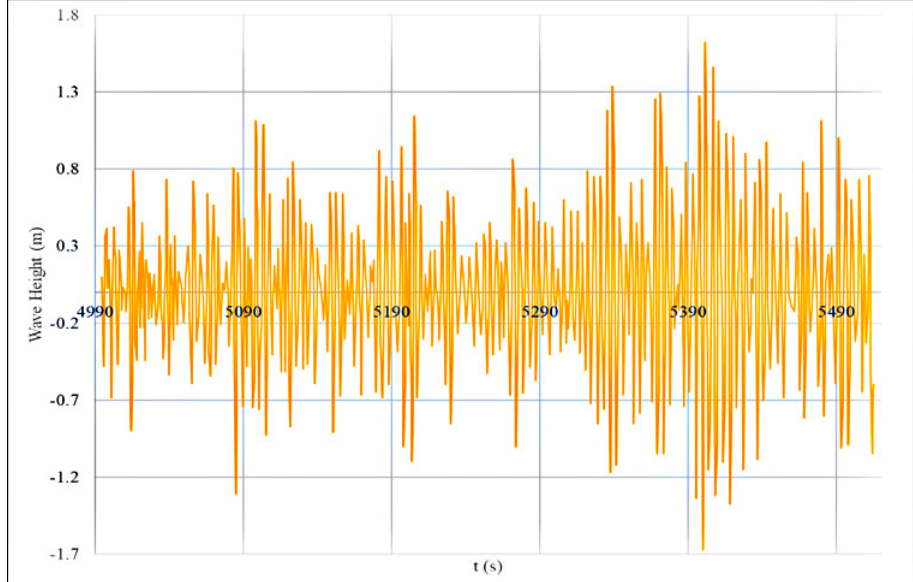
Figure 6. The wave height during the period of the experimental test.